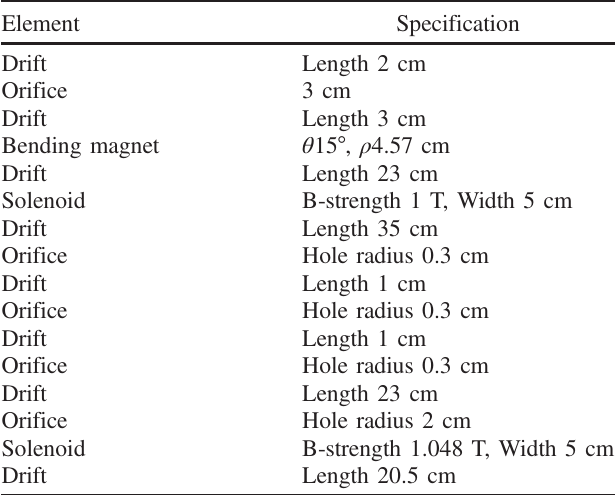
TABLE IV. LEBT design for deuteron acceleration. The charge neutralization effect was assumed to be 90% during LEBT transportation. θ and ρ represent the bend angle and curvature radius for the bending magnet,